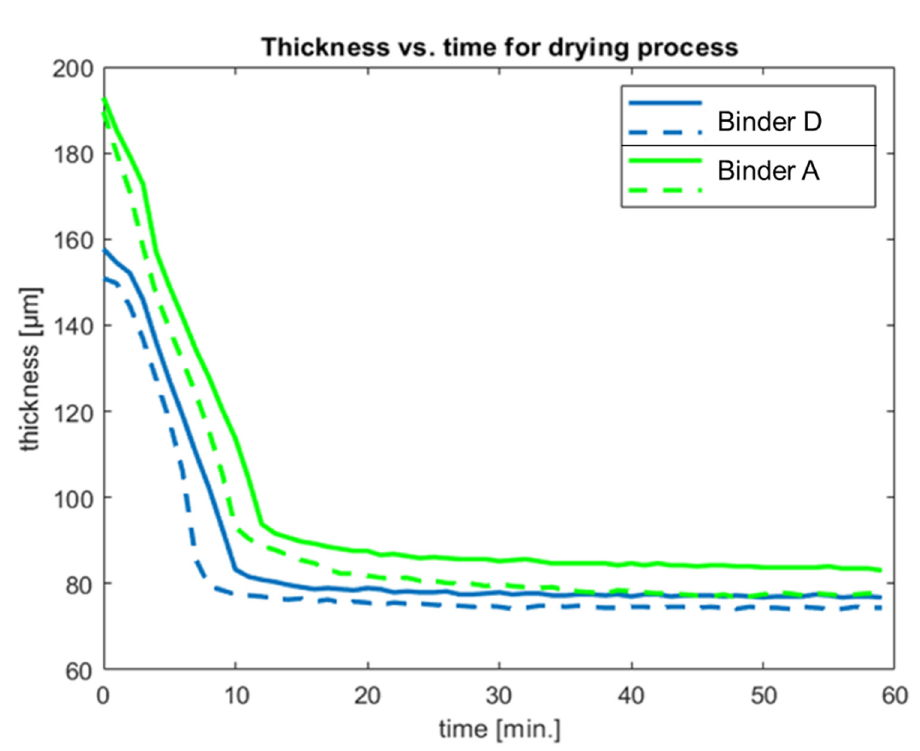
Figure 7. Drying kinetics of the reference latex A and the new binder D. Each binder was studied twice (solid and dashed lines). The thickness decline over time is very similar for all of the curves shown.